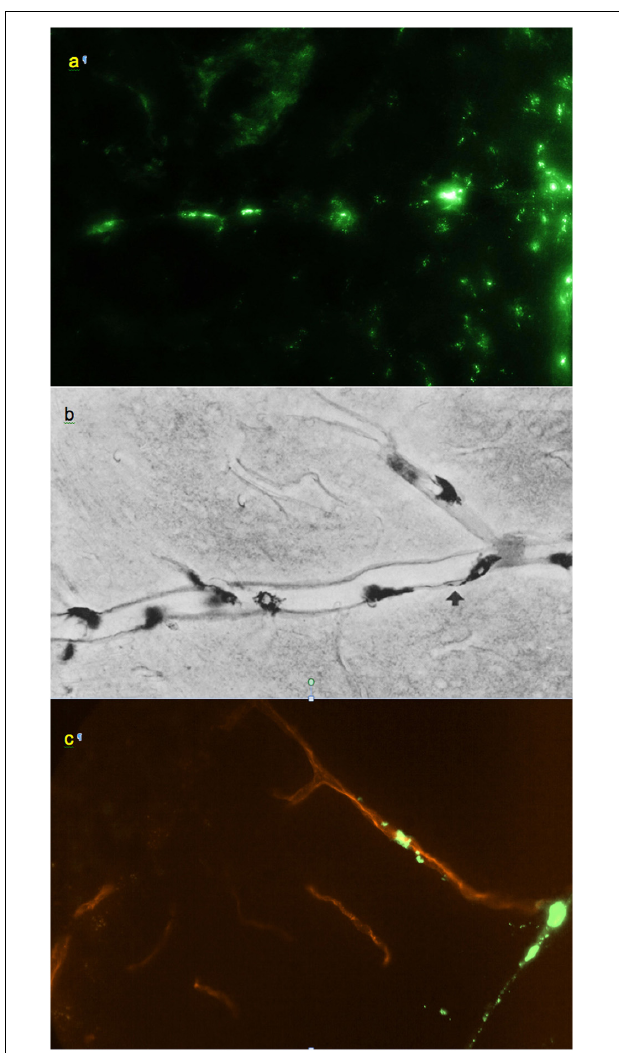
FIGURE 3 | (a) Small regularly labeled perivascular conduit extending from the surface of the frontal cortex, 0.6 mm × 0.4 mm. (b) From Wagner et al. (1974): analogous perivascular conduit (“space”), peroxidase/3,3 (cid:48) -diaminobenzidine staining. Reprinted by permission from Springer Nature. (c) Irregularly labeled perivascular channel in the cerebellum, 0.9 mm × 0.6 mm. (a,c) Unstained unfixed 20 µ m coronal cryosections. Red: blood vessel extending from a cerebellar